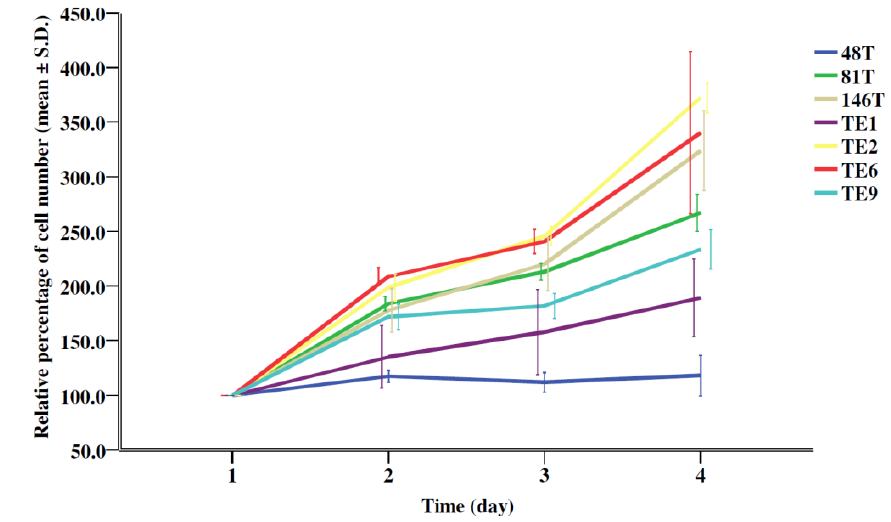
Figure 3. Growth kinetics of the seven ESCC cell lines. Data are shown in percentage when the cell number on day 1 is defined as 100.0%. The graph was plotted by using the SPSS 12.0 software (SPSS Inc, Chicago, IL, USA).